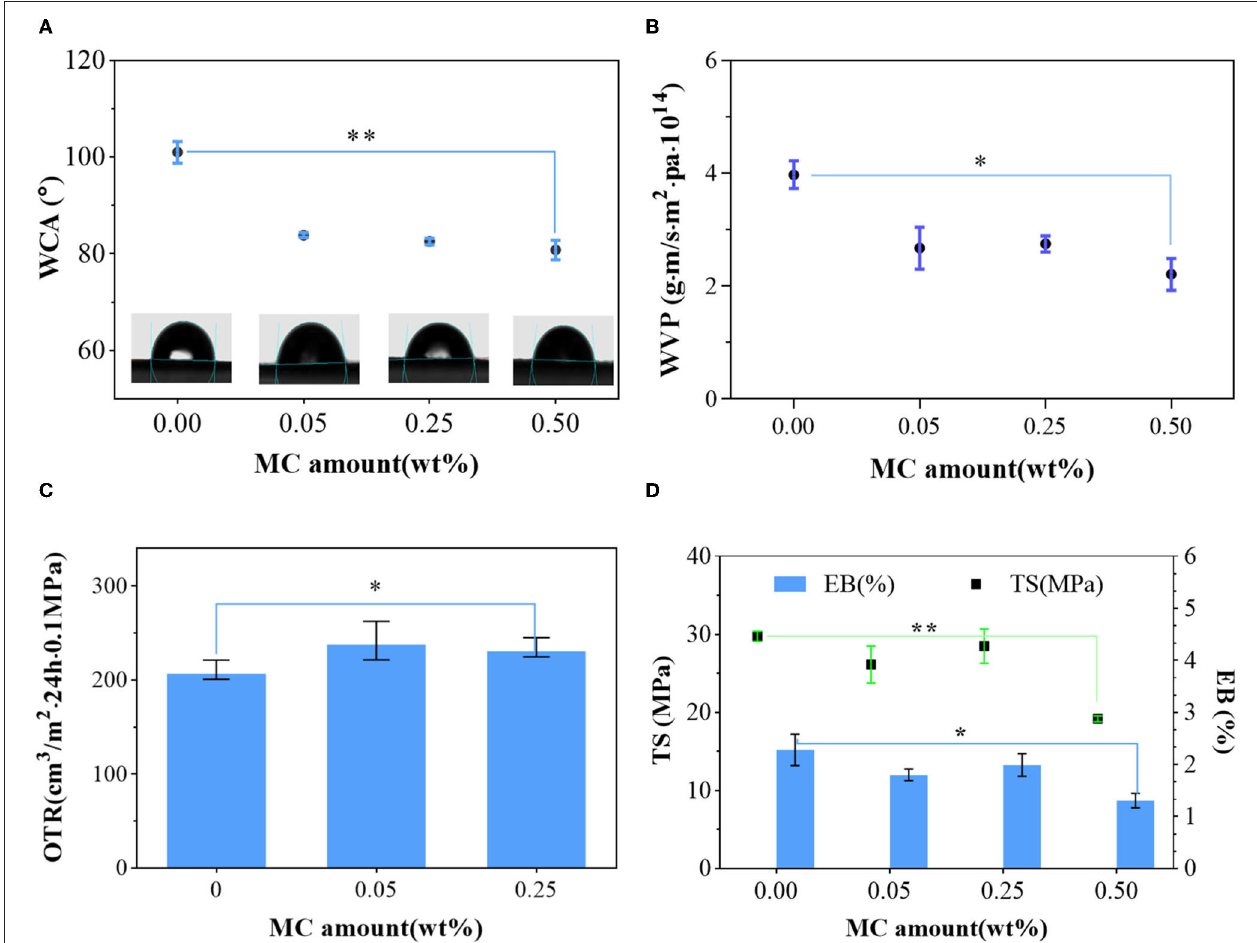
FIGURE 4 | Mechanical and barrier properties of the PLA film and PLA–MC films: (A) microscopic images of water droplets on the surface of PLA film and different PLA–MC films, and the corresponding water contact angle (WCA) values; (B) water vapor permeability (WVP) of PLA film and PLA–MC films; (C) oxygen transmission rates (OTRs) of PLA film and PLA–MC films; (D) tensile strength (TS) and elongation at break (EB) between PLA film and PLA–MC films. *indicates the difference is significant at the 0.05 level. **indicates the difference is significant at the 0.01